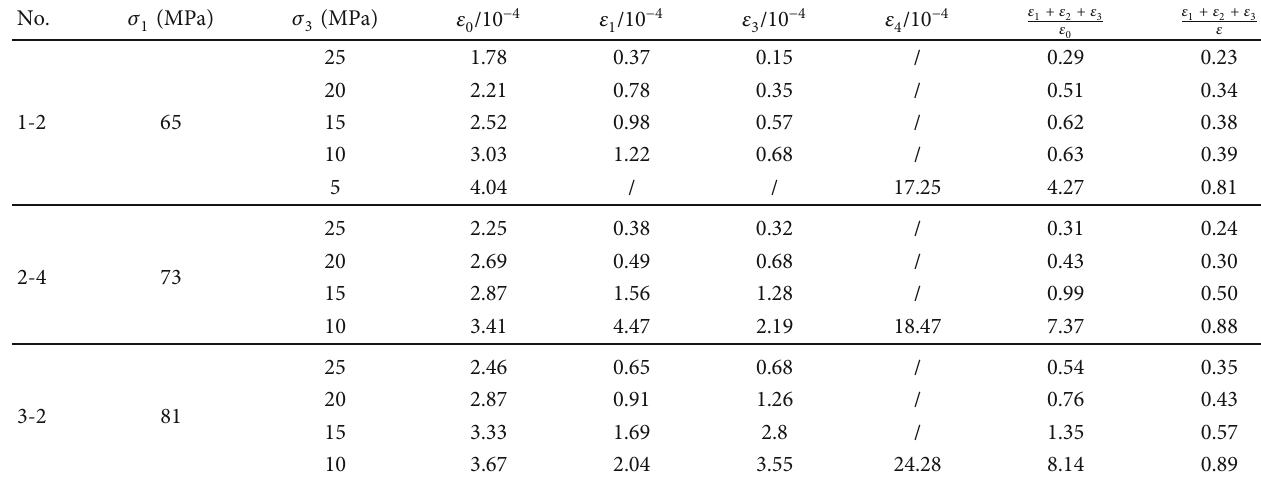
Table 2: Creep deformation